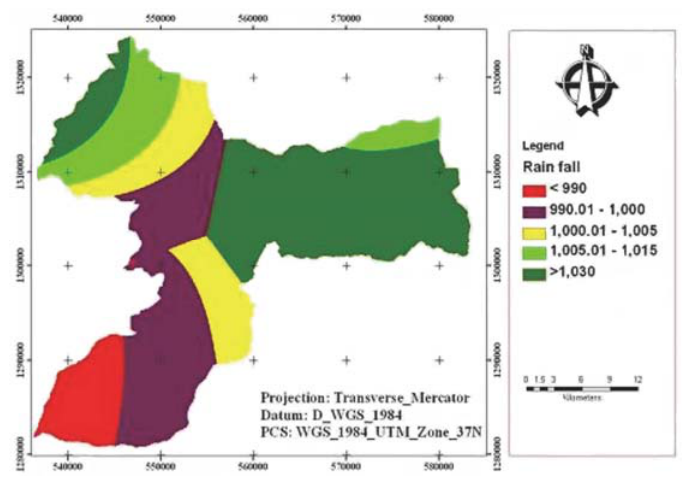
Figure 3. Rainfall map of Gubalafto district.